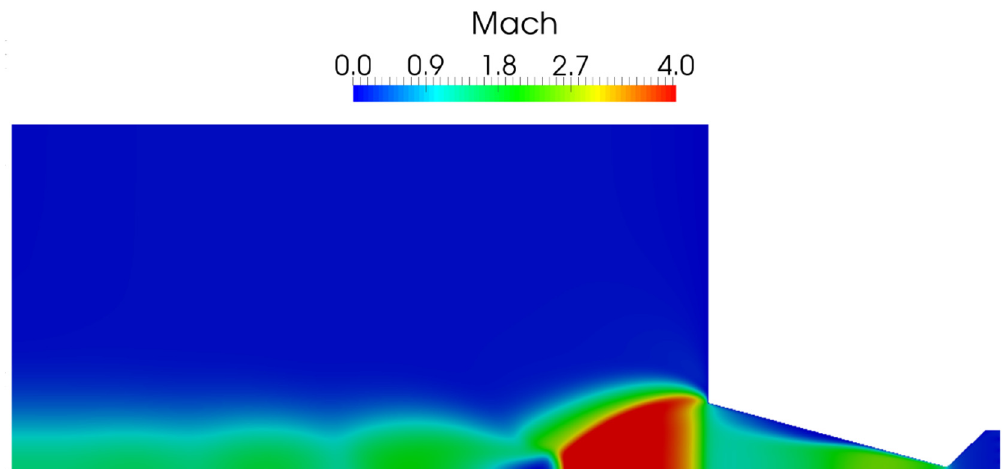
Figure 4. Contour plot of the Mach number for the baseline configuration of the water vapor flow (test case H2O_1).